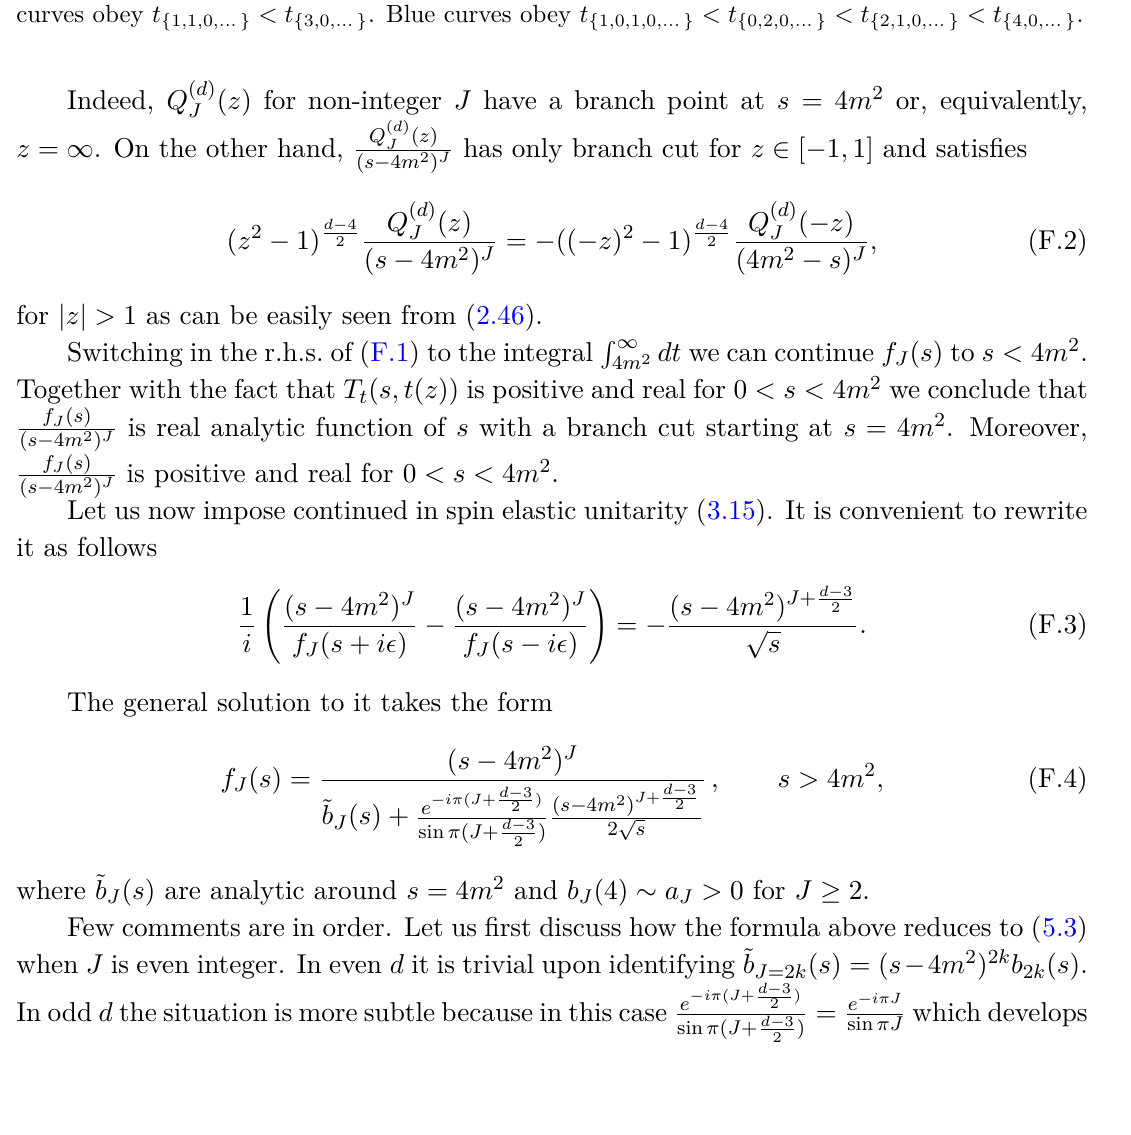
Figure 15 . Plot of the Landau curves given by equations (E.11) to (E.13) for m = 1 . The curves are organized by color according to the asymptote at t → ∞ . Black is the leading curve t curves obey t < t . Blue curves obey t { 1 , 1 , 0 ,... } { 3 , 0 ,... }